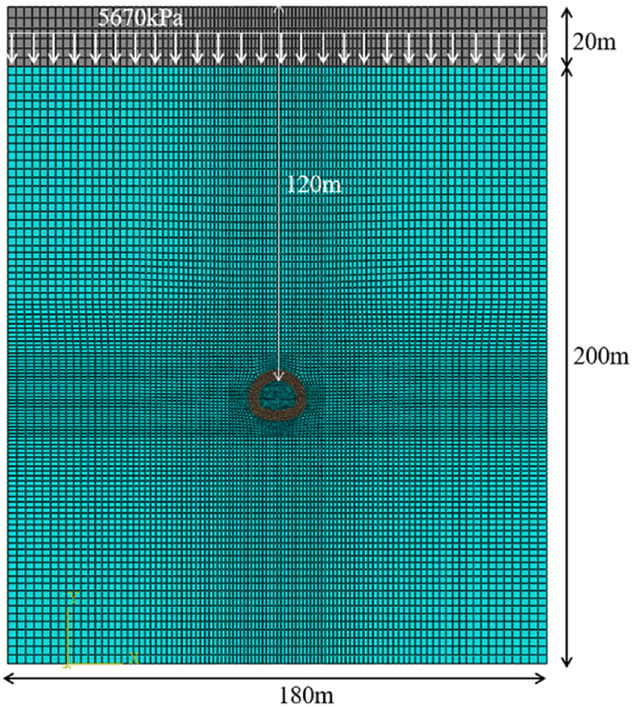
Figure 15. Calculation model of the typical section of the Xujiadi tunnel. Table 1. Physical and mechanical parameters of materials in